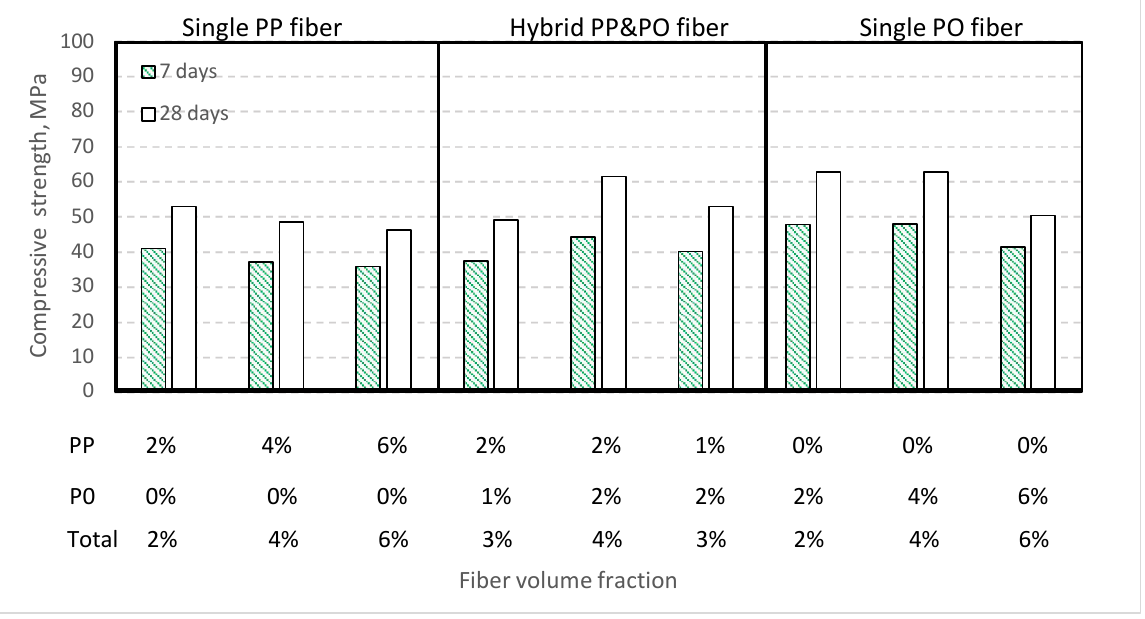
Figure 14. Effect of lightweight and heavyweight fiber hybridization on 7 and 28-day concrete com- pressive strength. 4.4.2. Splitting Tensile Strength Figures 15 and 16 represent the effect of fiber hybridization on 28-day concrete tensile strength. From these figures, hybridization has an effective role in enhancing tensile strength. Hybridization with 2% polypropylene fiber with 1% polyolefin fiber enhanced the tensile strength by 69.08% compared with the specimen reinforced with 2% polypro- pylene fiber. The addition of 2% polyolefin fiber enhanced the tensile strength by 88.40%, which is higher than the enhancement that occurred in the first case by 2.79%. Adding 1% PO fiber with 2% PP fiber yields higher tensile strength than all PP single fiber mixtures with different fiber volume fractions.